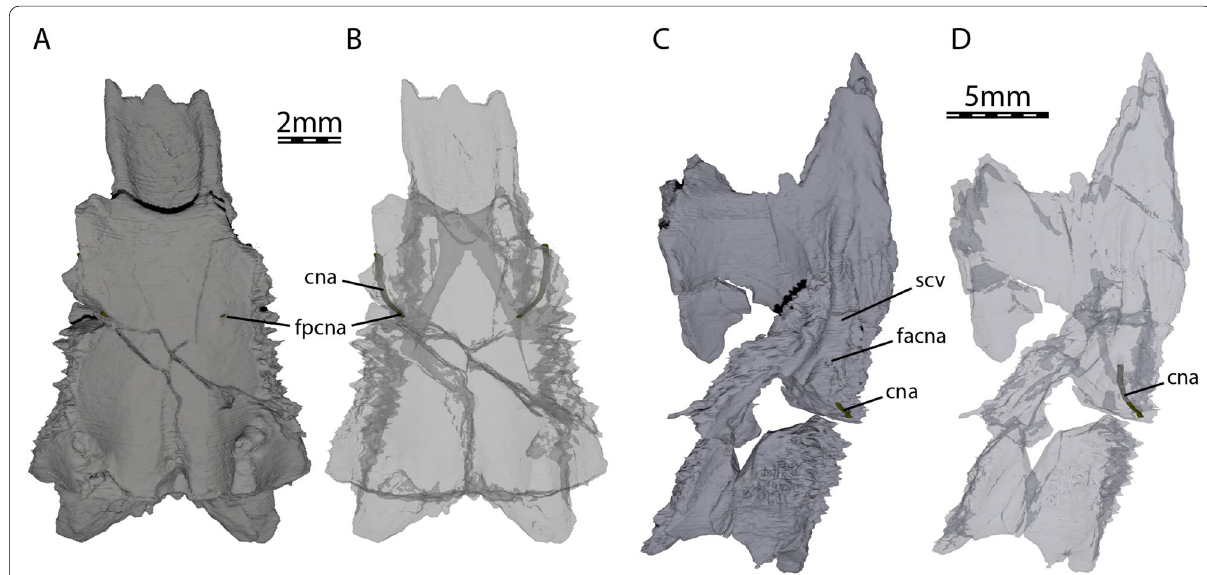
Fig. 7 Three-dimensional renderings of the parabasisphenoid, left pterygoid, and canalis nervus abducentis of UCM 53971. A Dorsal view of the parabasisphenoid, B dorsal view of the transparent parabasisphenoid highlighting the path of the abducens nerve, C dorsal view of the left pterygoid, and D dorsal view of the transparent left pterygoid highlighting the path of the abducens nerve. cna canalis nervus abducentis, facna foramen anterius canalis nervi abducentis, fpcna foramen posterius canalis nervi abducentis, scv sulcus